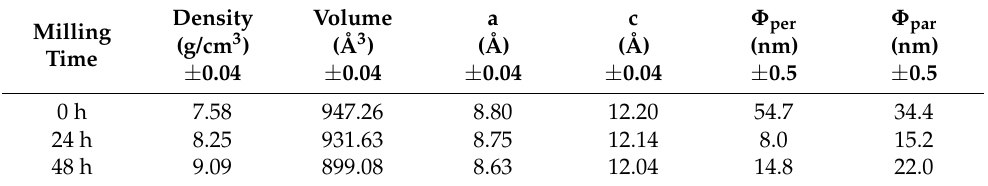
Table 5. Mössbauer parameters of the commercial Nd 2 Fe 14 B system for 48 h of milling time with oleic acid as a surfactant. The column with (HF) corresponds to the hyperfine field; and the lines with (J1, J2, K1, K2, C, E) correspond to the non-equivalent crystallographic iron site for Nd 2 Fe 14 B).